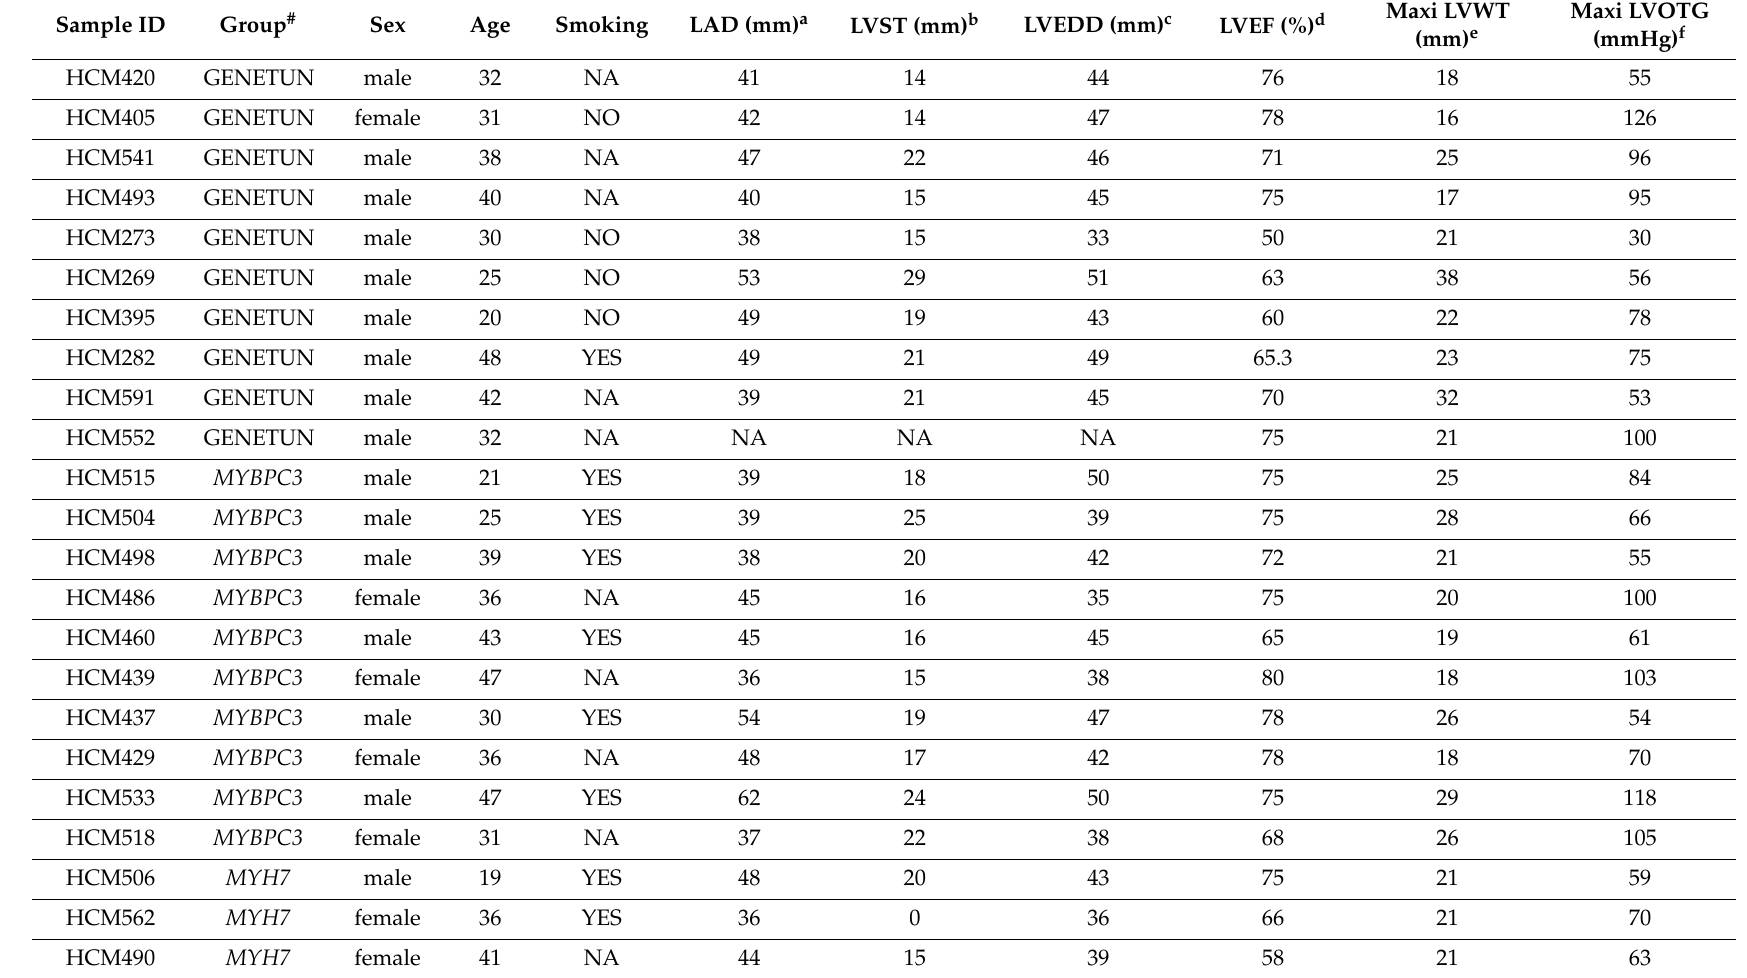
Table 1. Clinical characteristics of the studied samples